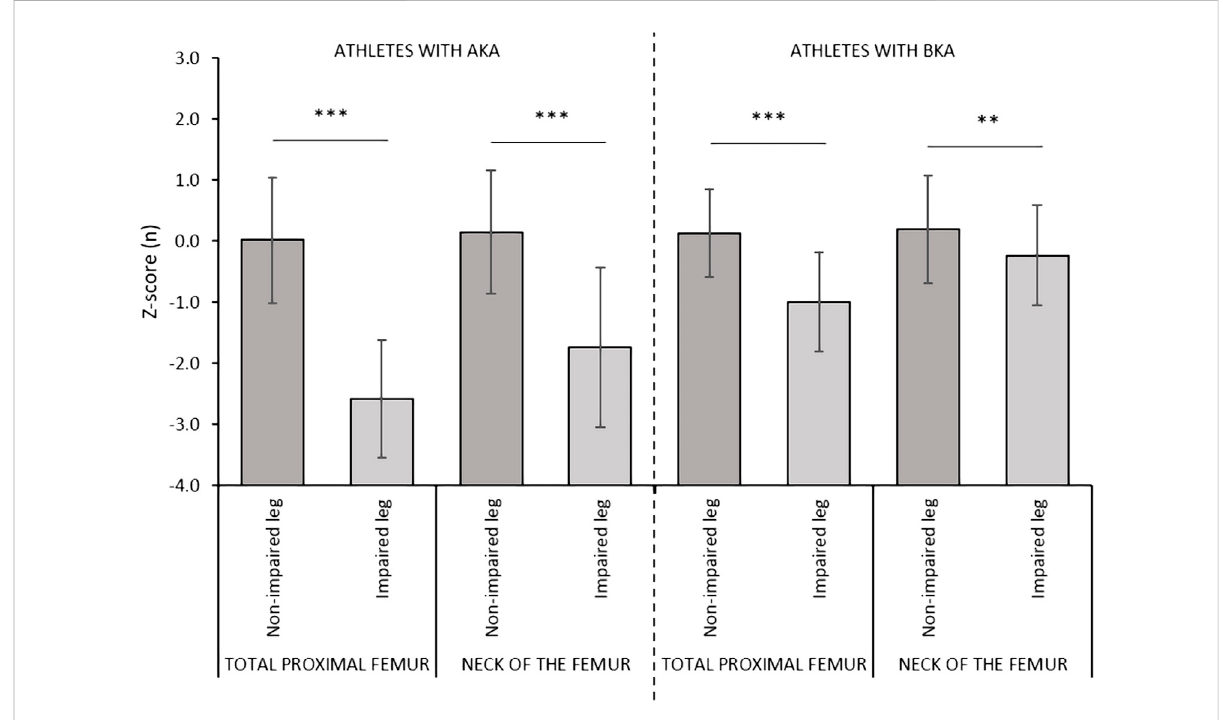
FIGURE 3 Comparisons of the Z-scores values between the impaired and non-impaired leg according to the level of amputation. Data are presented as mean ± standard deviation. Legend. AKA, above-knee amputation; BKA, below-knee amputation. *p ≤ 0.05; **p ≤ 0.01; ***p ≤